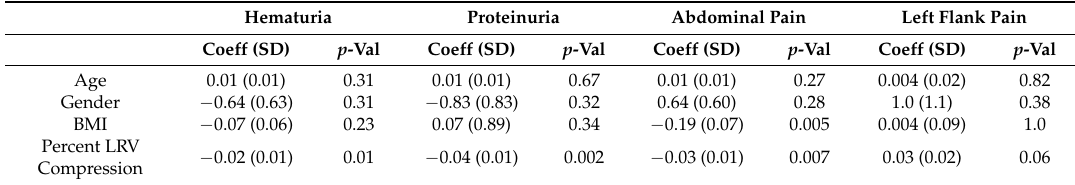
Table 3. Multi-logistic regression model for impact of age, gender, BMI, percent left renal vein compression on symptom and laboratory presentation.